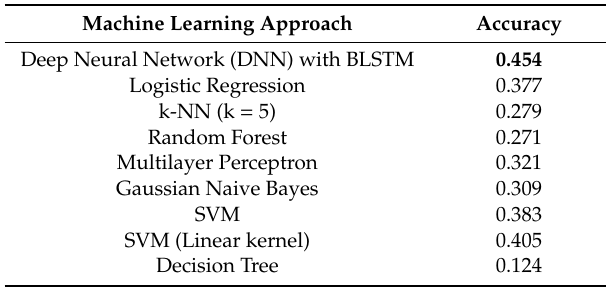
Table 3. The performance of our original FastText WE system that was used in some ML algorithms in terms of validation accuracy (bold indicates best scores of all